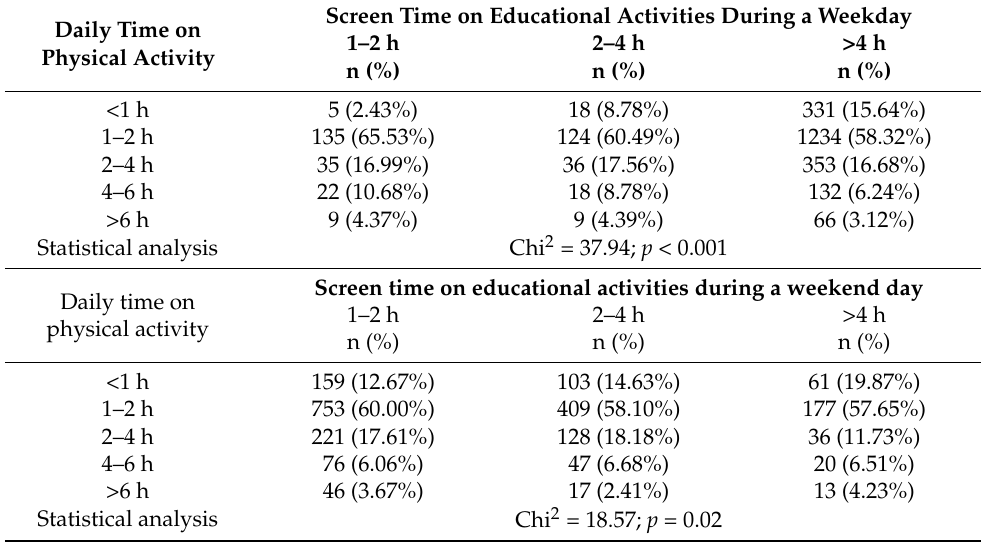
Table 6. Association between daily physical activity and screen